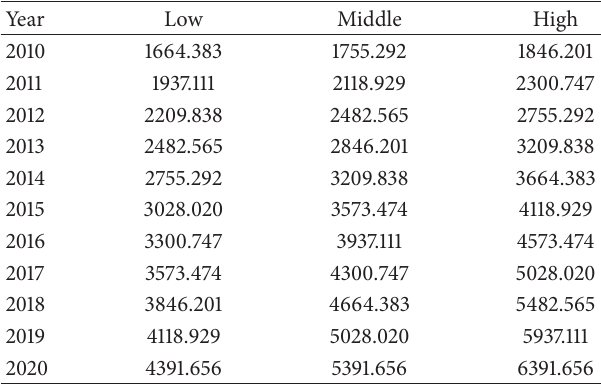
Table 3: Possible scenarios (low, middle, and high) for future motor vehicle ownership (in thousands) in Cambodia for the years